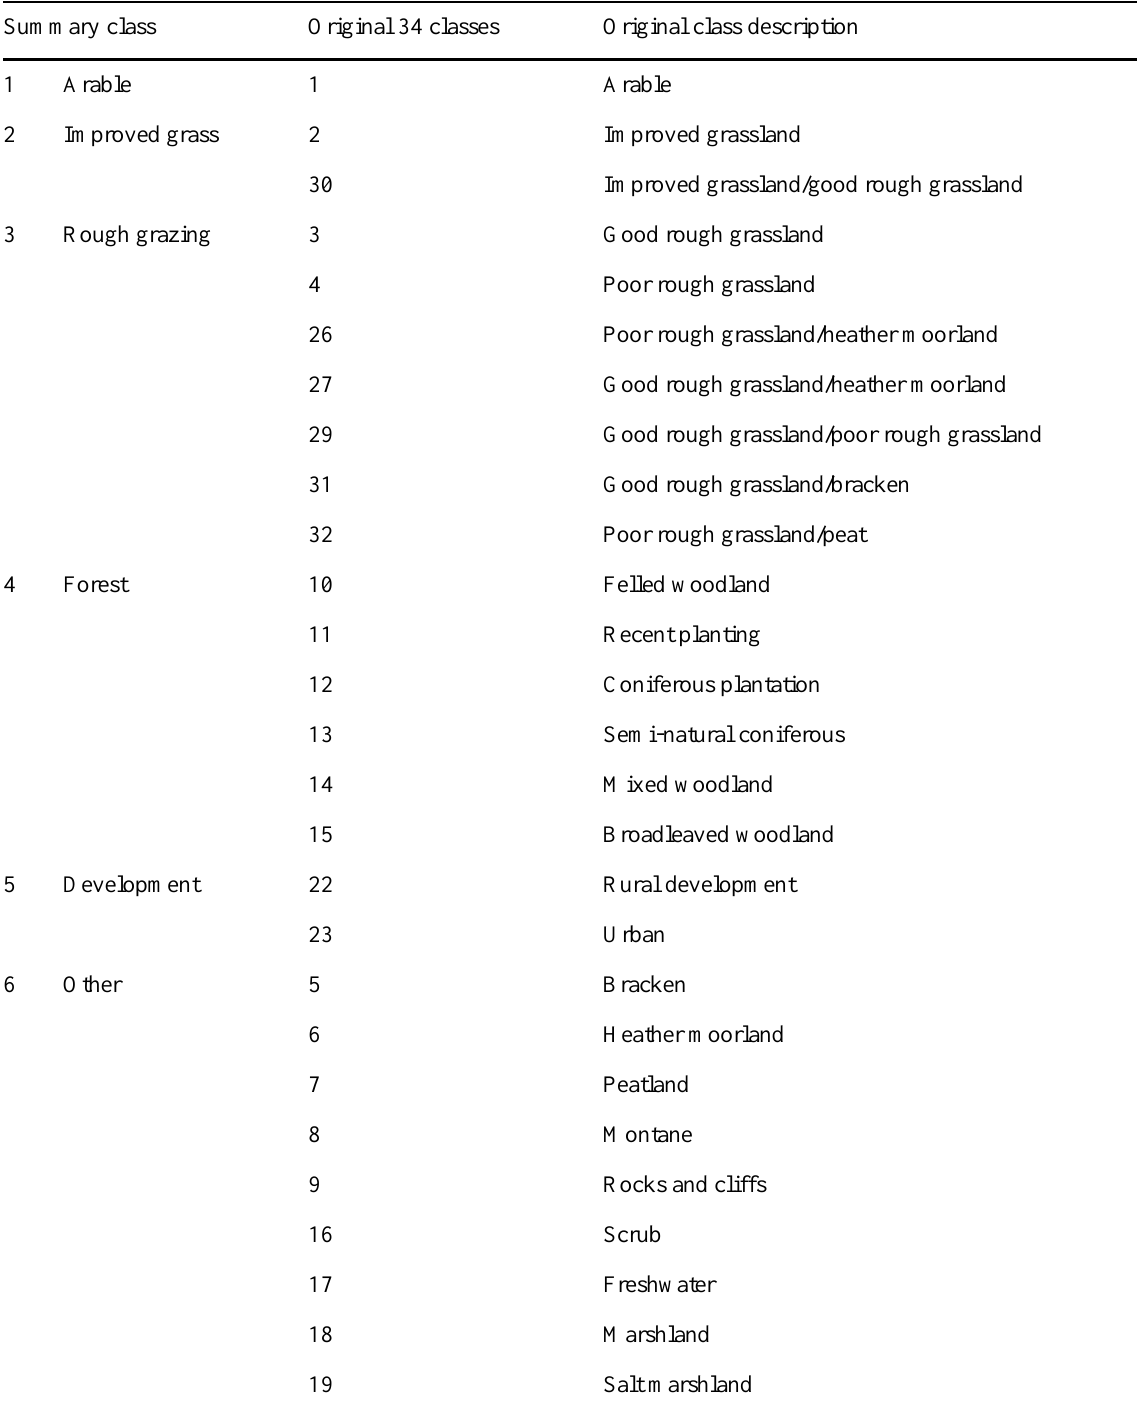
Table 1. Summary classes of